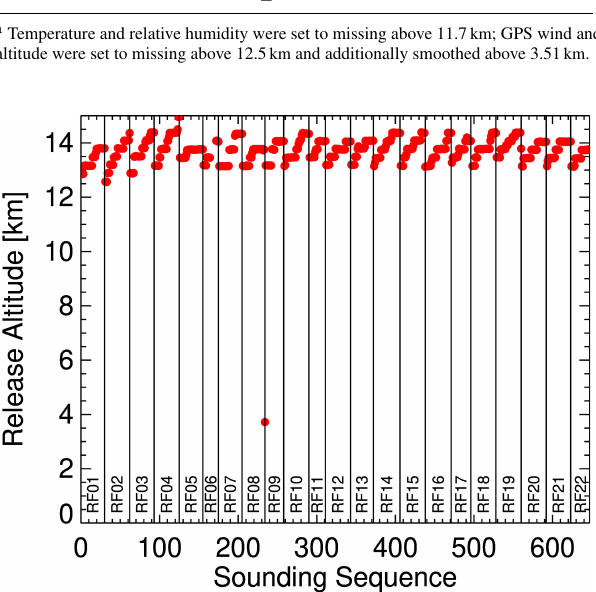
Table 6. Fast-fall soundings. No.